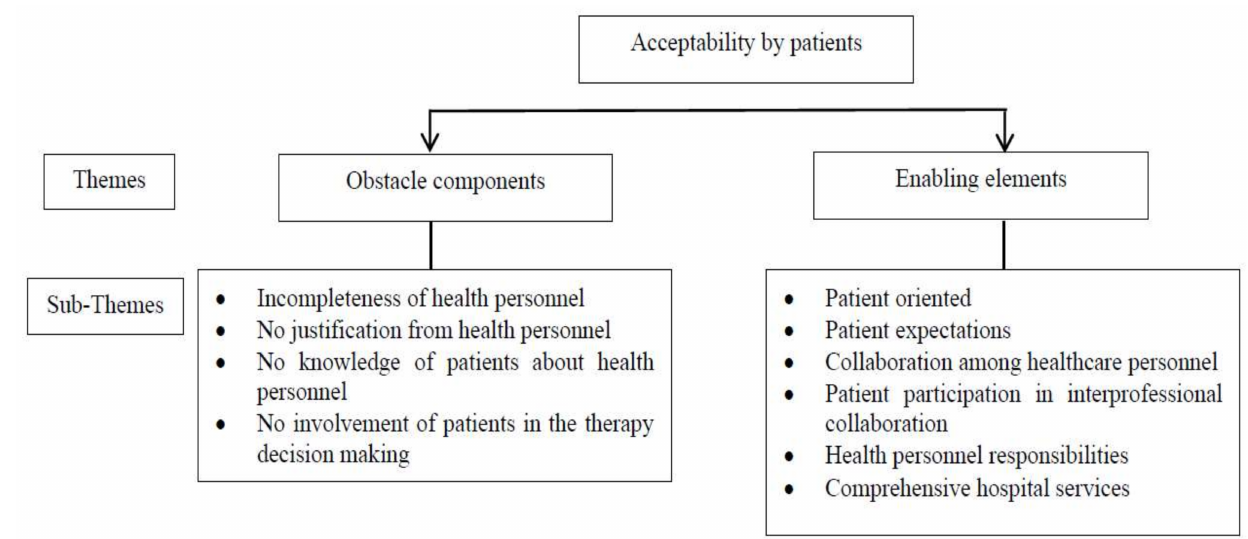
Figure 1. Acceptability by patients regarding interprofessional collaboration.